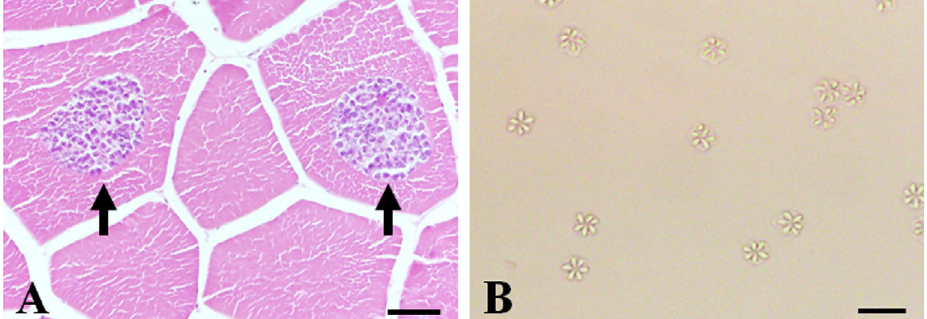
Figure 1. (A) Histology of olive fl ounder ( Paralichthys olivaceus ) muscles showing muscle fi bers containing Kudoa septempunctata spores. Arrows indicate spore-containing cysts. Hematoxylin and eosin staining. (B) Microscopy of isolated K . septempunctata spores from olive fl ounder muscles. Scale bars: A, 100 m m; B, 10 m